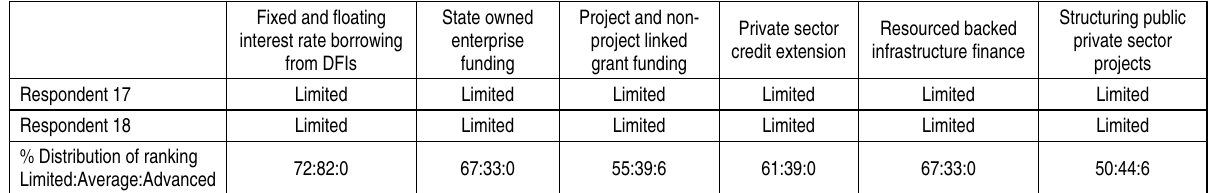
Table 2 (cont.). Rating of working knowledge with finance models